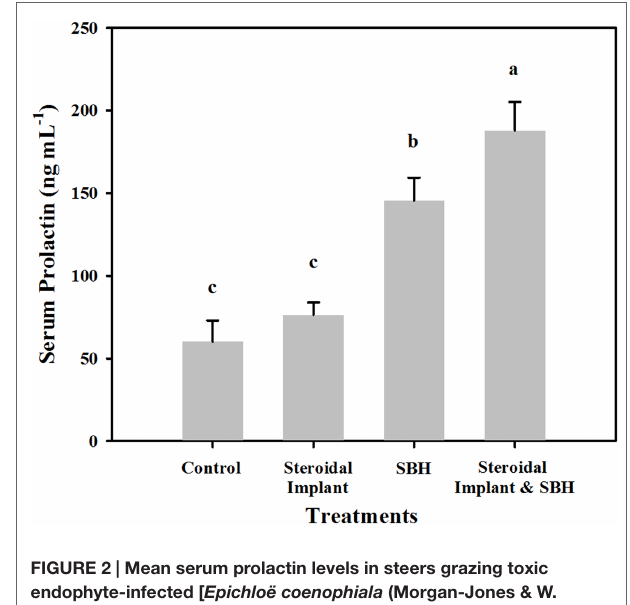
FigUre 1 | Mean estrogenic equivalents (e 2 eqs) in steers grazing toxic endophyte-infected [ Epichloë coenophiala (Morgan-Jones & W. gams) c. W. Bacon & schardl] tall fescue [ Lolium arundinaceum (schreb.) Darbysh] and treated ( n = 4 steers per treatment groups) with or without an estradiol–progesterone ear implant and soybean hull (sBh) feeding combinations . Values are averages over 2 years, two sample dates per year (6/14 and 7/5/2007; 6/24 and 7/24/2008). Means with different letters are different ( P ≤